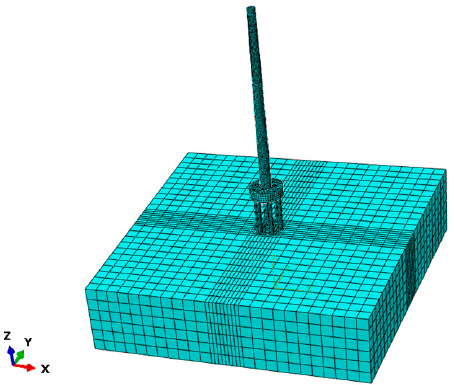
Figure 8. Meshing of the model.